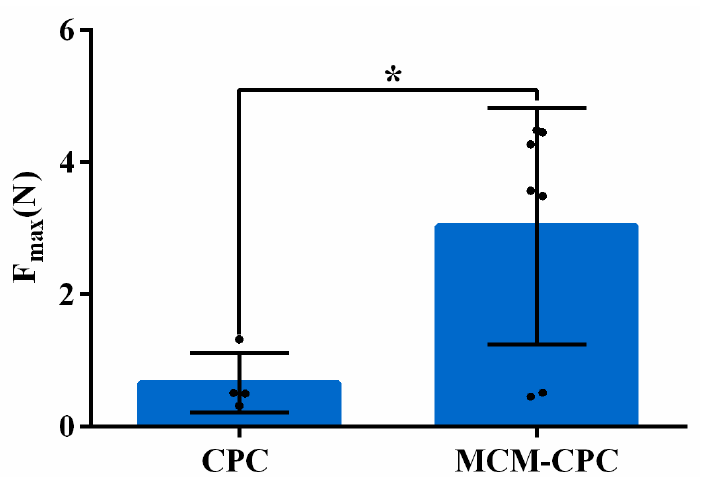
Figure 5. Maximum load applied to explants of the calcium phosphate cement (CPC) group and mineralized collagen matrix-calcium phosphate cement (MCM-CPC) group (F max : maximum force of bone defect breaking; mean ± SD, * p < 0.05).